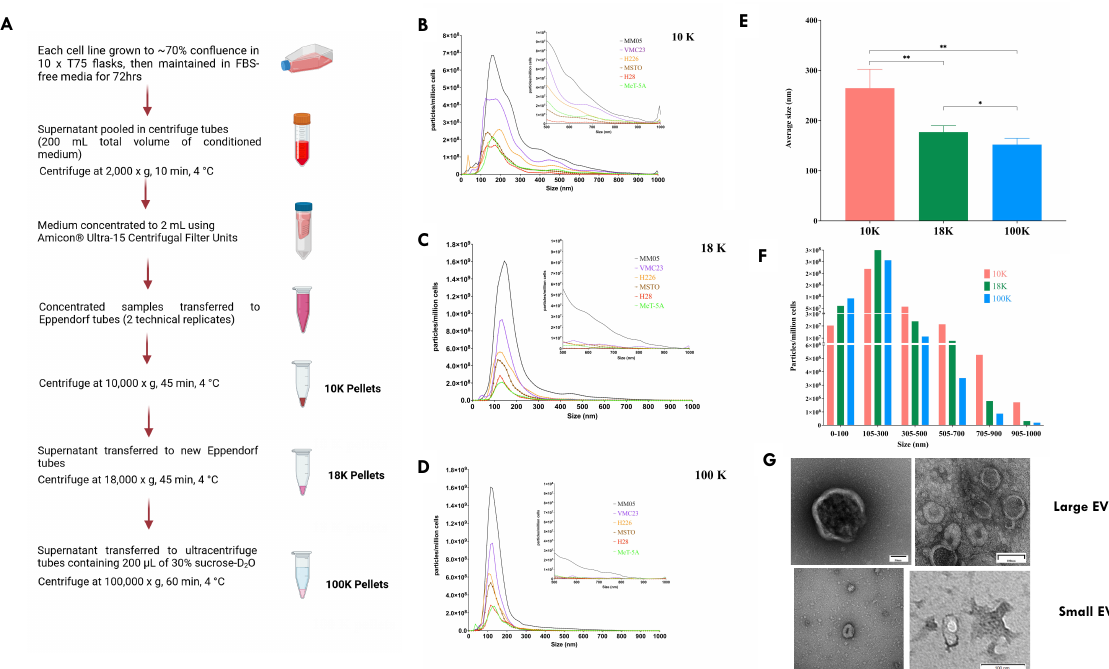
Figure 2. EV isolation, particle size distribution, and particle concentration. ( A ) Flowchart of the differential centrifugation and ultracentrifugation method used for EV isolation. ( B ) Size distribution and particle concentration profile of 10 K EV samples as measured using NTA. ( C ) Size distribution and particle concentration profile of 18 K EV samples as measured using NTA. ( D ) Size distribution and particle concentration profile of 100 K EV samples as measured using NTA. ( E ) Comparison of the average size of particles in 10 K, 18 K, and 100 K pellets, as measured using NTA. ( F ) Particle concentration of 10 K, 18 K, and 100 K according to size clusters, showing the dominant EV type in each size range, as measured using NTA. ( G ) Transmission electron microscopy showing cup-shaped EV morphology for large and small EVs. * p ≤ 0.05, ** p ≤ 0.01.